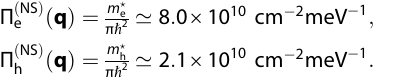
= 5.9 × 10 10 cm − 2 0